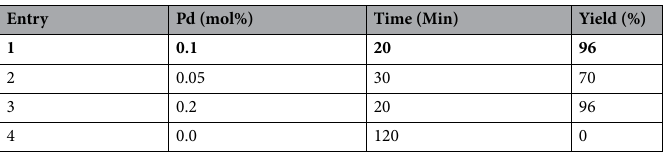
Table 5. Variation of catalyst load. Reaction conditions: 4-methylbromobenzene (1.0 mmol), phenylboronic acid (1.0 mmol), K 2 CO 3 as base (2 mmol), EtOH/H 2 O (1:1) as solvent (3 mL) at 50 °C; Isolated yield.